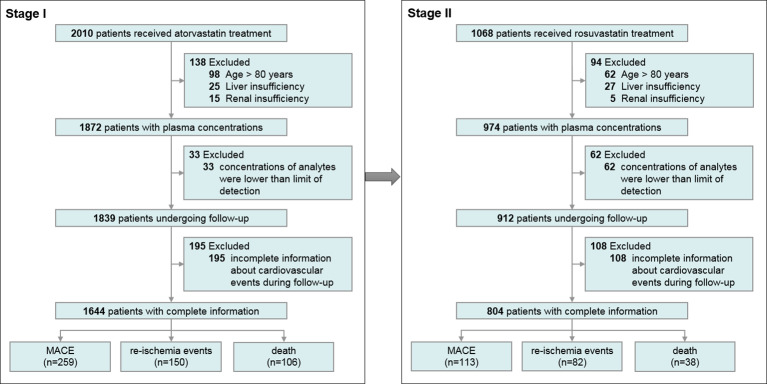
Flow chart of the enrolment of the participants.